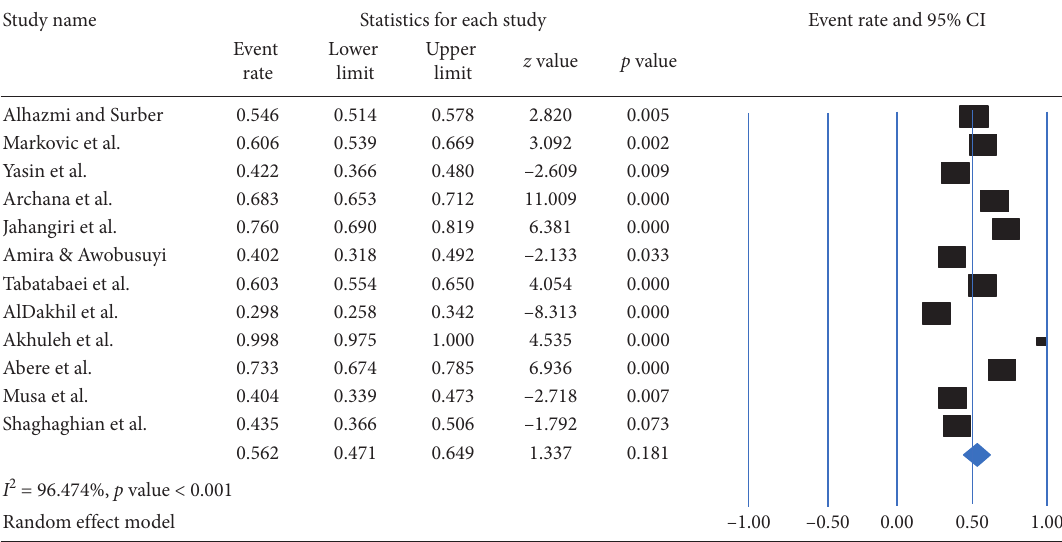
Figure 2: Forest plot shows the pooled prevalence of career time occupational exposure to needle stick injury among healthcare workers.